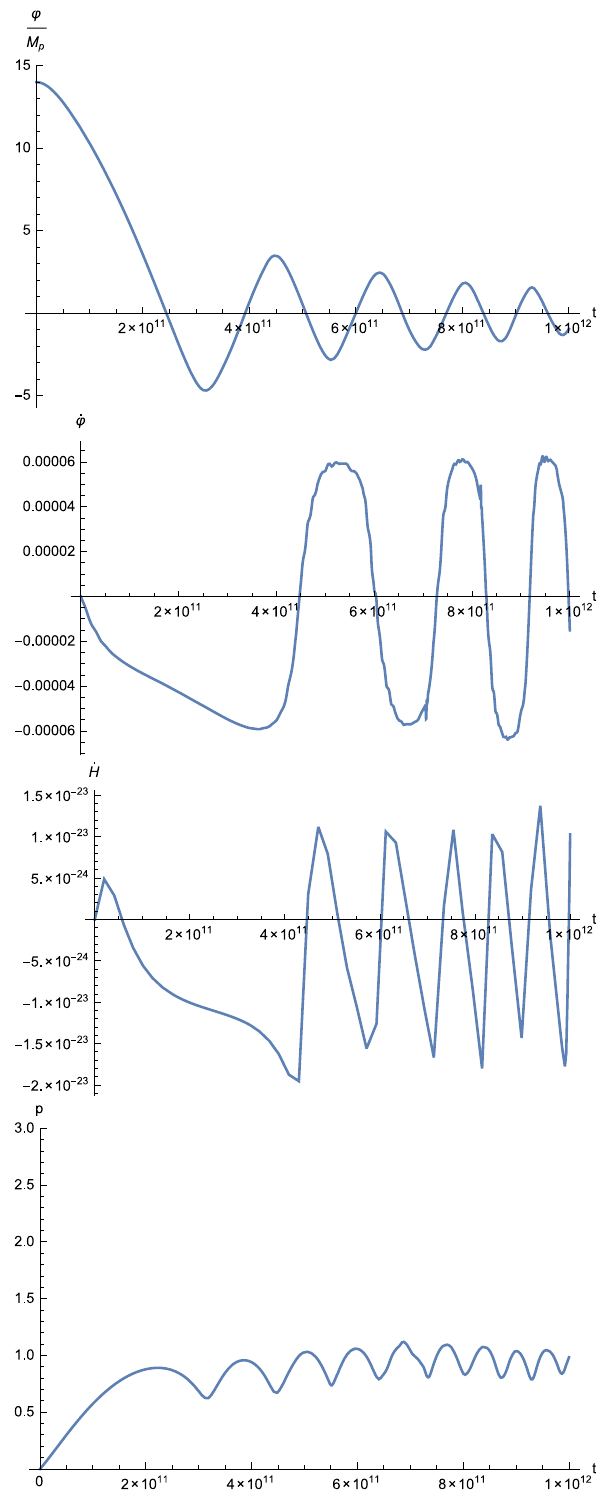
Fig. 2 Plots of the value of ϕ , ˙ ϕ , the parameter p in Eq. (11) and ˙ H in terms of cosmic time t . We choose the parameters as ξ = 1, M = 10 − 4 M p , m = 10 − 6 M